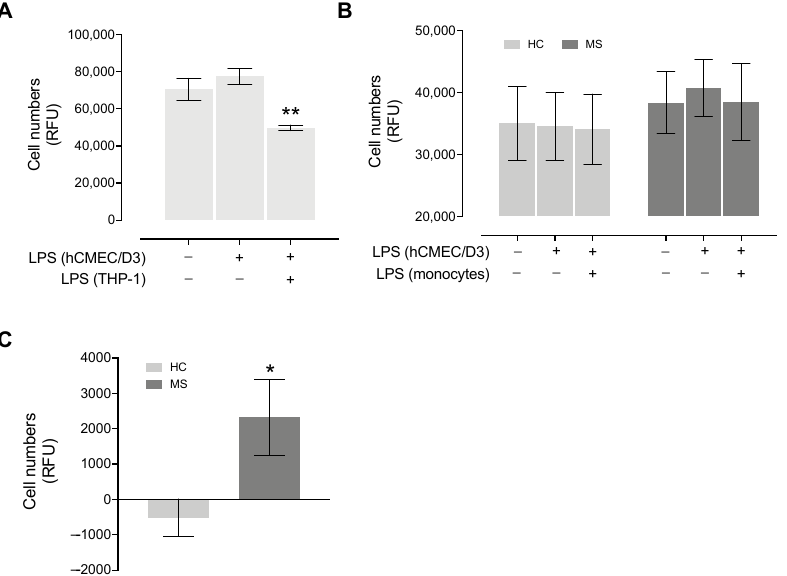
Figure 3. Migration rate of THP-1 and primary monocytes collected from MS and HC subjects. ( A ) Migrating THP-1 cells (expressed as Relative Fluorescence Units, RFU) through hCMEC/D3 cells’ monolayer were measured without stimulation, pre-stimulating hCMEC/D3 cells with LPS for 24 h or pre-stimulating hCMEC/D3 cells, as well as stimulating THP-1 cells with LPS for 24 h. The